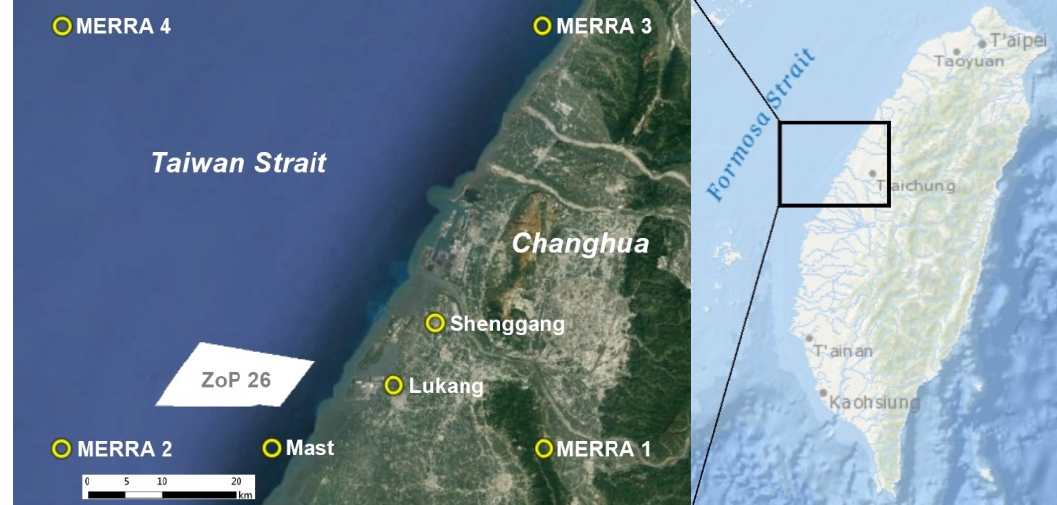
Figure 2. Locations of wind farm in ZoP 26, Taipower meteorological mast, MERRA locations 1–4, and CWB stations at Lukang and Shenggang.